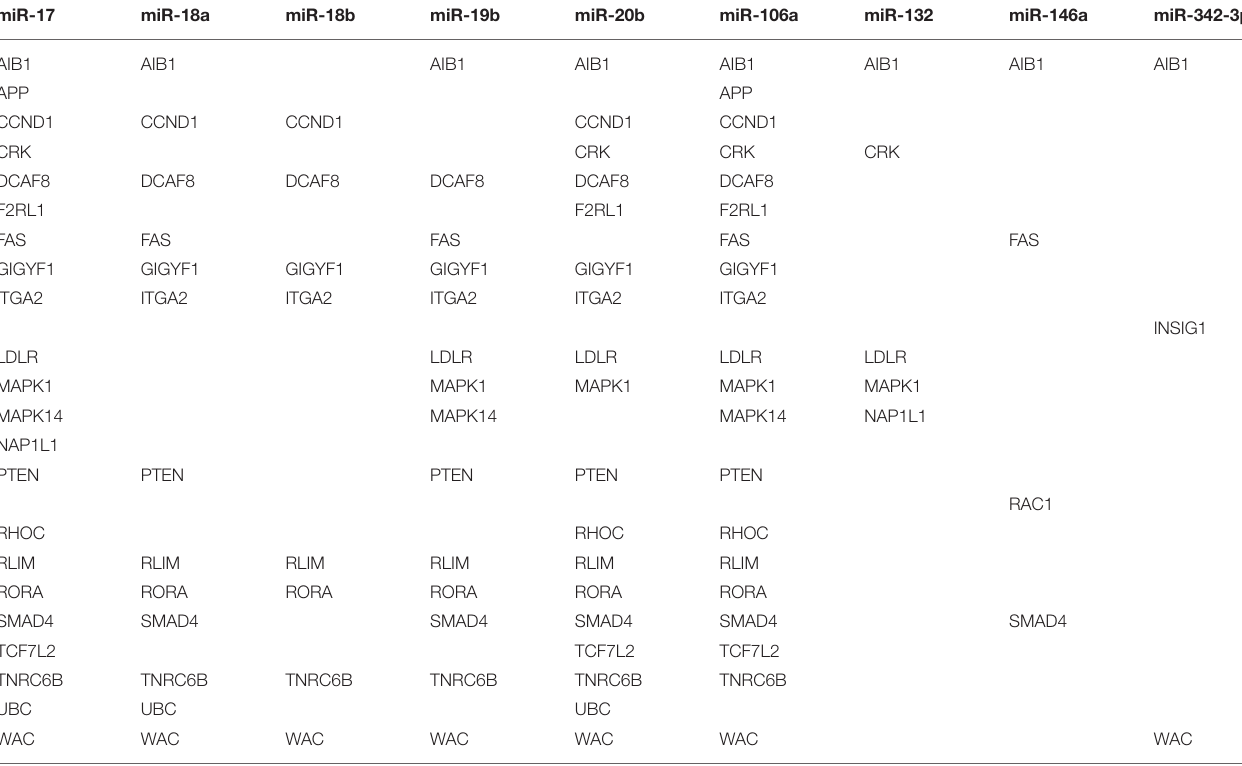
TABLE 2 | List of genes putatively targeted by the nine monocyte subset-specific miRNAs. miR-17